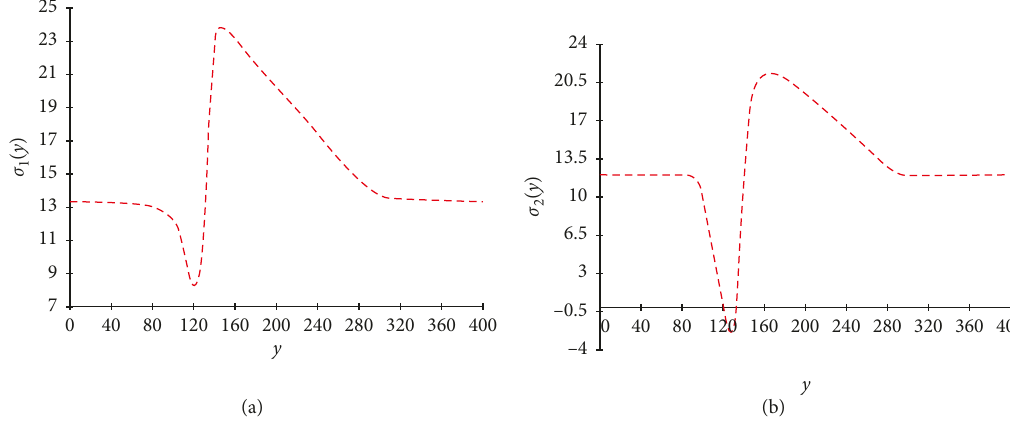
F IGURE 10: The change of the maximum principal stress and the minimum principal stress along the strike direction at point M. (a) Maximum principal stress. (b) Minimum principal